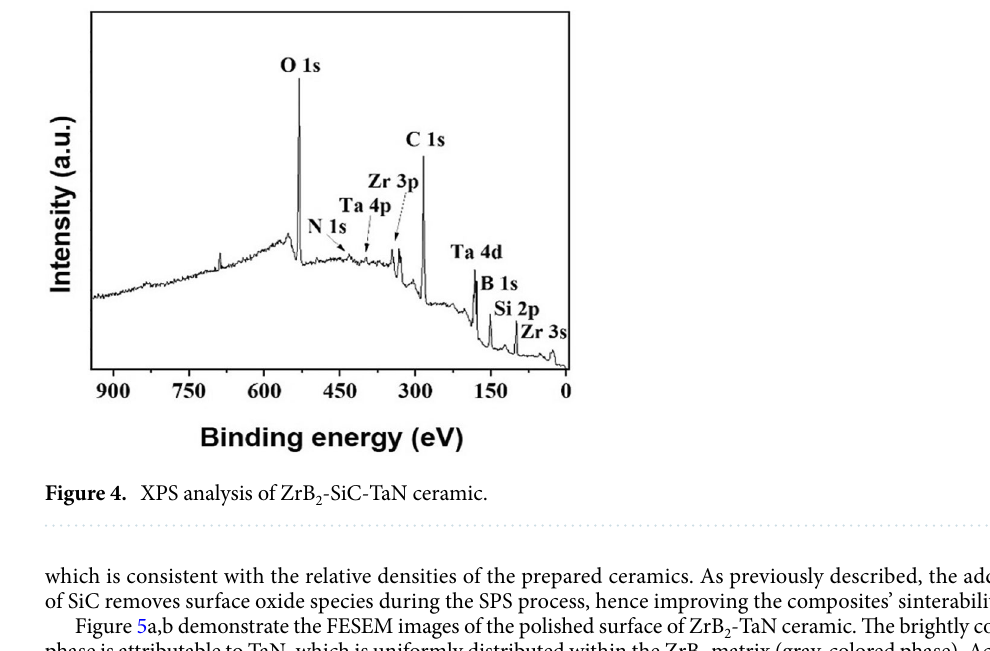
which is consistent with the relative densities of the prepared ceramics. As previously described, the addition of SiC removes surface oxide species during the SPS process, hence improving the composites’ sinterability. Figure 5a,b demonstrate the FESEM images of the polished surface of ZrB 2 -TaN ceramic. The brightly colored phase is attributable to TaN, which is uniformly distributed within the ZrB 2 matrix (gray-colored phase). Accord- ing to the EPMA analysis (Fig. 5c–f), diffusion occurred between ZrB 2 and TaN compounds at their interfaces. In such areas, the formation of solid solutions (Zr, Ta, and BN) is probable. By comparing Fig. 5d,f, it is possible to deduce that certain regions are rich in both boron and nitrogen. These sites can be seen clearly in Fig. 5d (red zones). This outcome is entirely consistent with the XRD analysis, specifically the in situ formation of the hBN phase as a result of an interaction between ZrB 2 and TaN constituents at the interfaces. During the elemental diffusion between these two phases, some boron and nitrogen atoms may leave their places in the crystalline structures, contributing to the in situ production of hBN phase. Figure 6a,b present FESEM micrographs of the polished surface of ZrB 2 -SiC-TaN ceramic. According to the EPMA analysis (Fig. 6c–h), the brilliant, dark, and gray phases are related with the TaN additive, the SiC rein- forcement, and the ZrB 2 matrix, respectively. The uniform distribution of TaN and SiC within the ZrB 2 matrix indicates that the powder mixture was properly prepared. Similar to ZrB 2 -TaN ceramic, diffusion bonds are vis- ible in the ZrB 2 -TaN and ZrB 2 -SiC interfacial regions. Furthermore, the formation of hBN is possible anywhere boron and nitrogen concentrations are high (Fig. 6d,h). Figure 7a depicts TEM image of the interaction of two adjacent ZrB 2 grains. It indicates that surface imper- fections could be eliminated during the SPS process, allowing neighboring ZrB 2 particles to form strong bonds. During the sintering process, certain dislocations are formed on both sides of the interfacial region due to the external pressure. The ZrB 2 /TaN interface appears neat (Fig. 7b). However, no visible grain boundary can be detected in the interfacial area image at high magnification (Fig. 7c). Consequently, these two phases may substantially diffuse together, producing a strong connection. The TEM micrograph and inverse fast Fourier transform (IFFT) image reveal the presence of dislocations within the TaN phase (Fig. 7d). In addition to exter- nal pressure (as a potential explanation for the production of dislocations), the mismatch between the thermal expansion coefficients of the available ingredients might lead to the formation of dislocations. This behavior would be more prominent during cooling stage of the sintering process. The ternary composite was examined utilizing the nanoindentation technique. Several load–displacement curves relating to different components of this composite are illustrated in Fig. 8. Due to the surface roughness, the calculation of hardness by Oliver-Pharr technique (see supporting information) leads to data propagation 39,40 . Hardness is significantly changed at the areas near the surface when the typical technique is applied to assess the penetration depth. For example, slippage of the indenter’s tip may occur under low stresses on protrusions. Consequently, the achieved value for the projected area/indentation depth can be greater than the values obtained on surfaces with depressions or flat surfaces, resulting in lower hardness values. In short, small wrinkling may lead to varied hardness values considering a single phase. According to Table 1, the following is the sequence of hardness, elastic modulus, and stiffness values for ZrB 2 and interfacial areas: SiC > ZrB 2 /SiC interface > ZrB 2 /TaN interface > ZrB 2 > TaN (hardness), ZrB 2 /TaN interface > SiC > ZrB 2 > TaN > ZrB 2 /SiC interface (elastic modulus), and ZrB line structure. The formation of strong bonds between adjacent phases enables the attainment of high mechanical characteristics for interface regions. ZrB 2 /SiC, for instance, could attain a hardness value of 25 GPa, which was greater than that of ZrB 2 . It is evident that SiC has a higher hardness compared to ZrB 2 ; however, the interface hardness may be significantly lower than surrounding phases if a powerful bonding would not be formed.